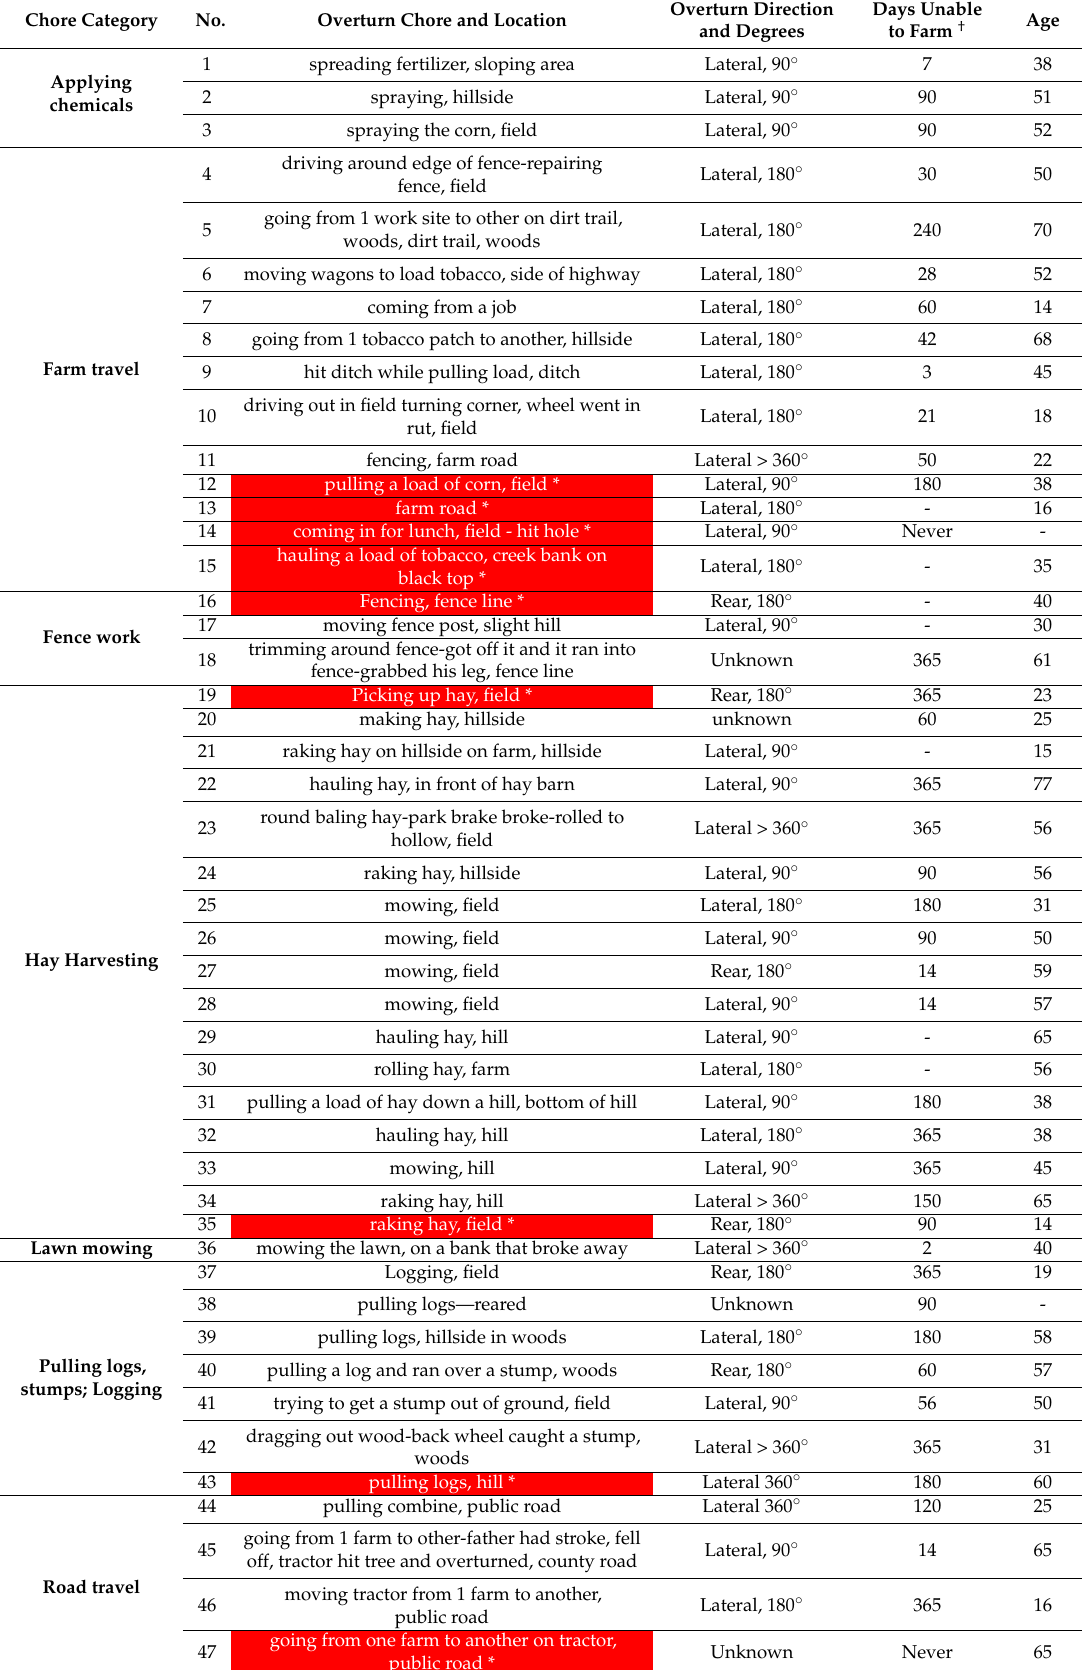
Table 6. Details of nonfatal non-ROPS tractor overturns by chore category, n = 64. Chore